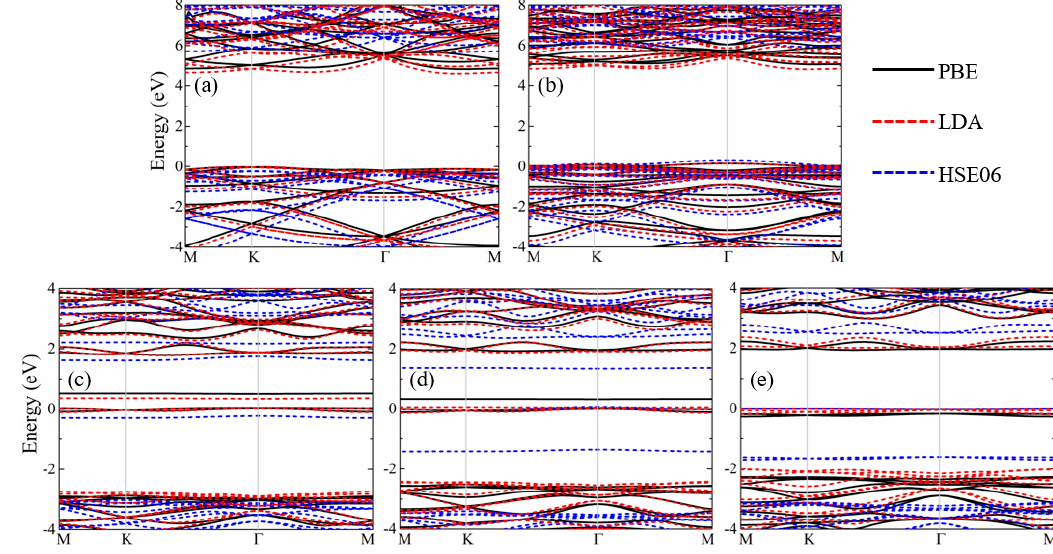
Figure A1. Band structures of Mg 9 H 18 ( a ); Mg 8 H 18 ( b ); Mg 8 H 18 Ti ( c ); Mg 8 H 18 V ( d ); and Mg 8 H 18 Mn ( e ) calculated using PBE (black line), LDA (red dot line), and HSE06 (blue dot line) functionals, respectively.